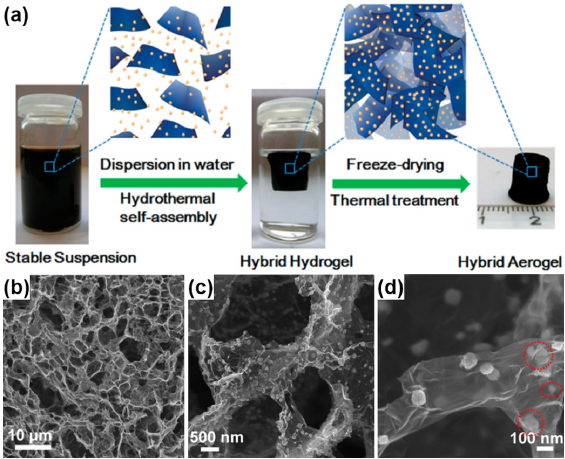
Figure 10. ( a ) Fabrication process for the 3D Fe 3 O 4 /N ‐ doped graphene aerogel catalyst. ( b – d ) SEM images of Fe 3 O 4 /N ‐ doped graphene aerogel revealing the 3D macroporous structure and uniform distribution of Fe 3 O 4 nanoparticles in the graphene aerogels. Reproduced with permission of Ref. [62] (Copyright American Chemical Society 2012).